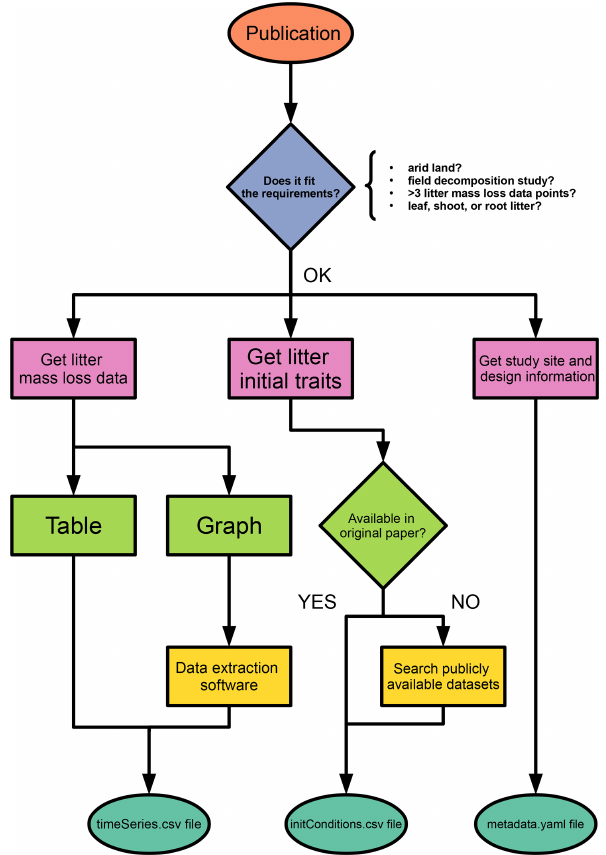
Figure 1. A guiding flowchart of the entry-submitting process for potential contributors of aridec